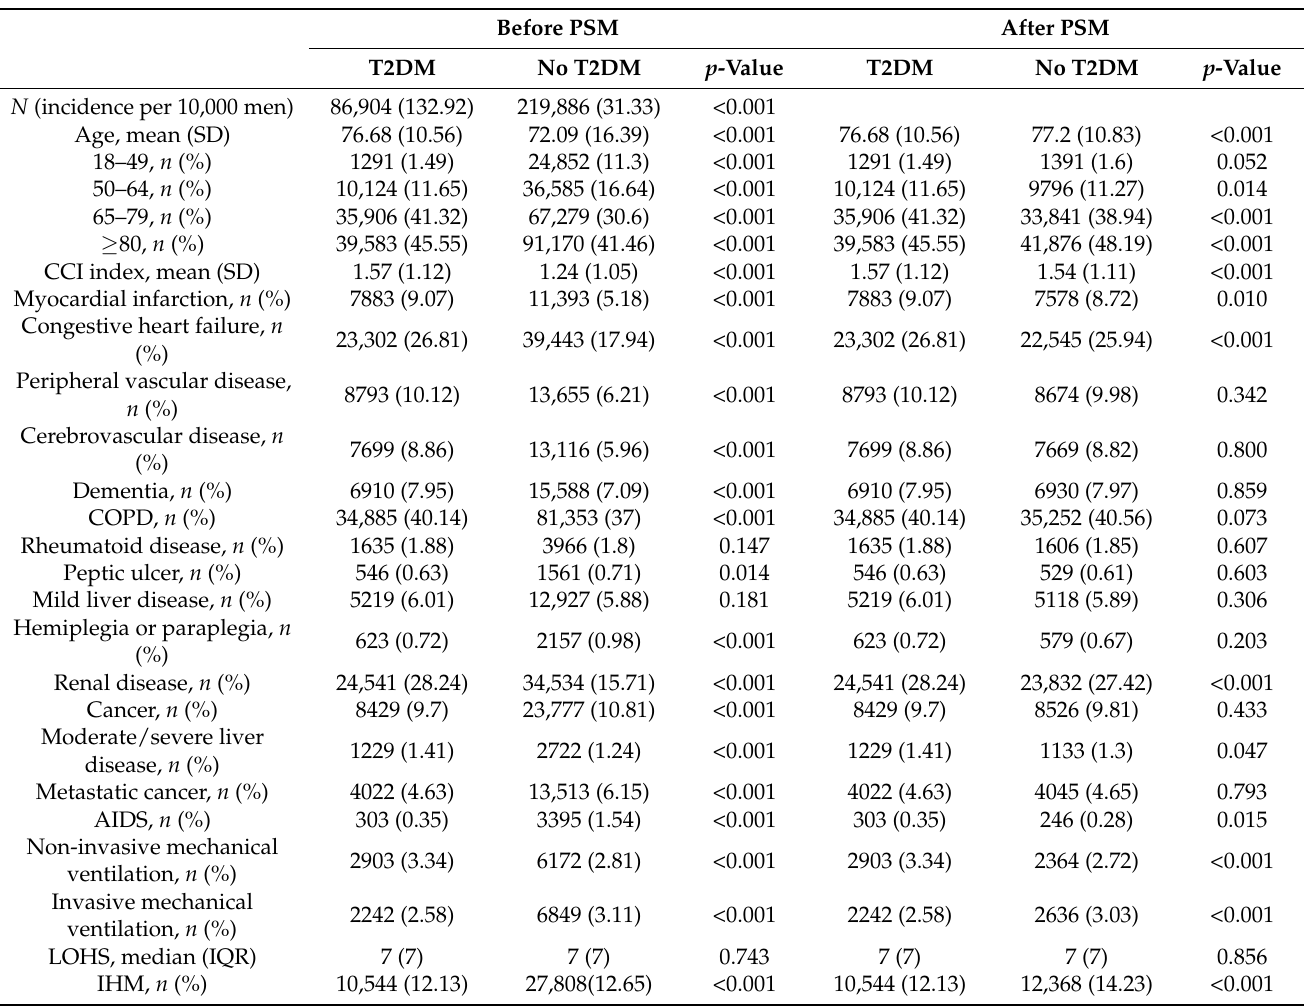
Table 3. Distribution of study covariates and hospital outcomes of men with and without T2DM hospitalized with community-acquired pneumonia (CAP) in Spain (2016–2019), before and after propensity score matching (PSM). Before PSM After